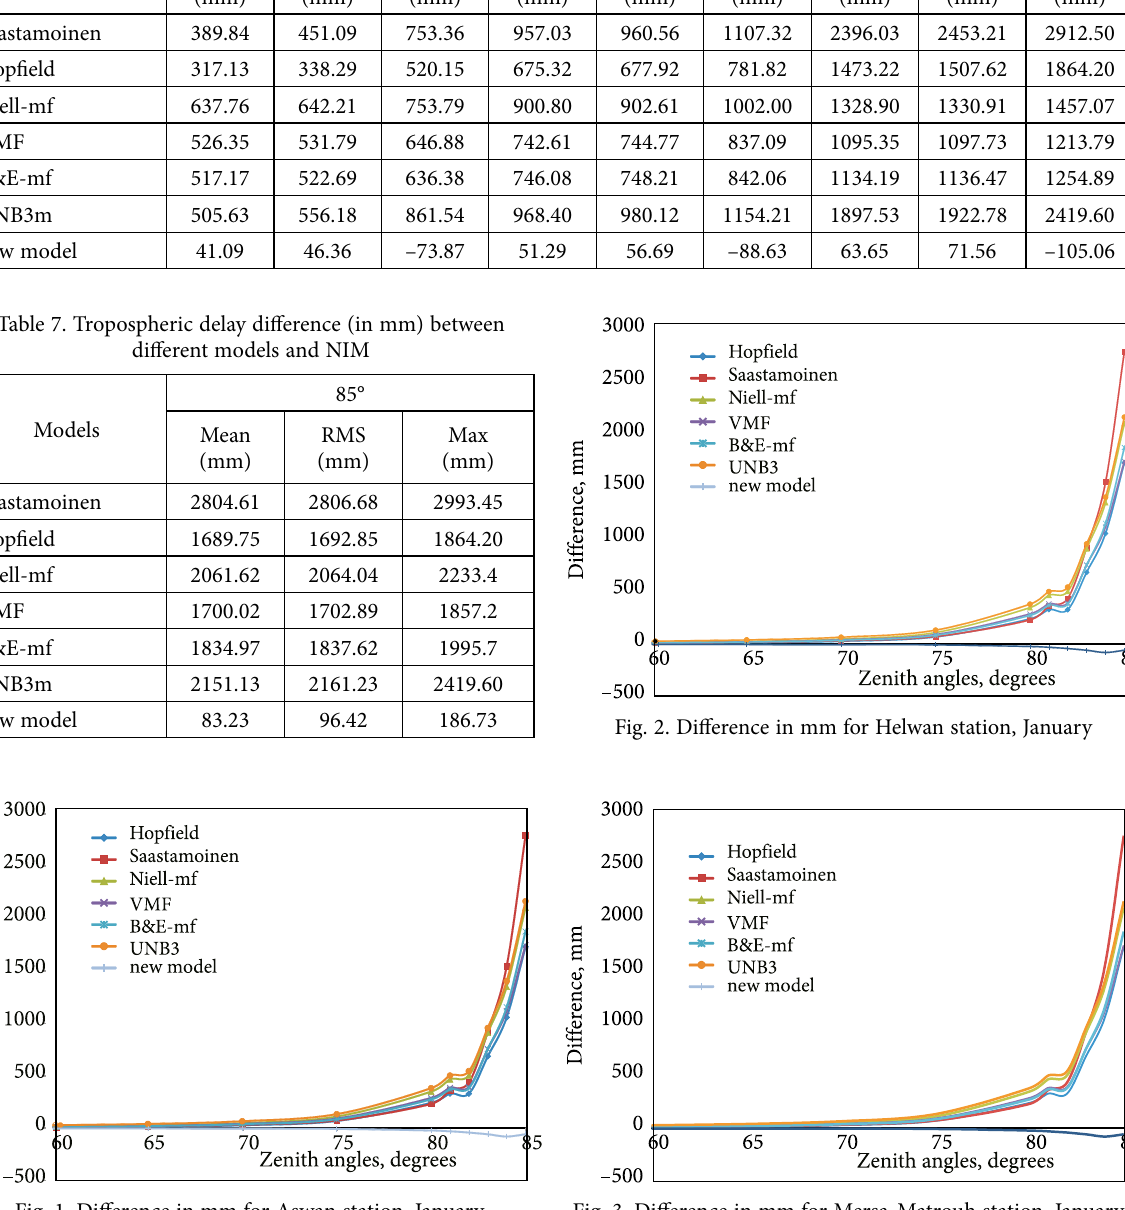
Fig. 1. Difference in mm for Aswan station, january